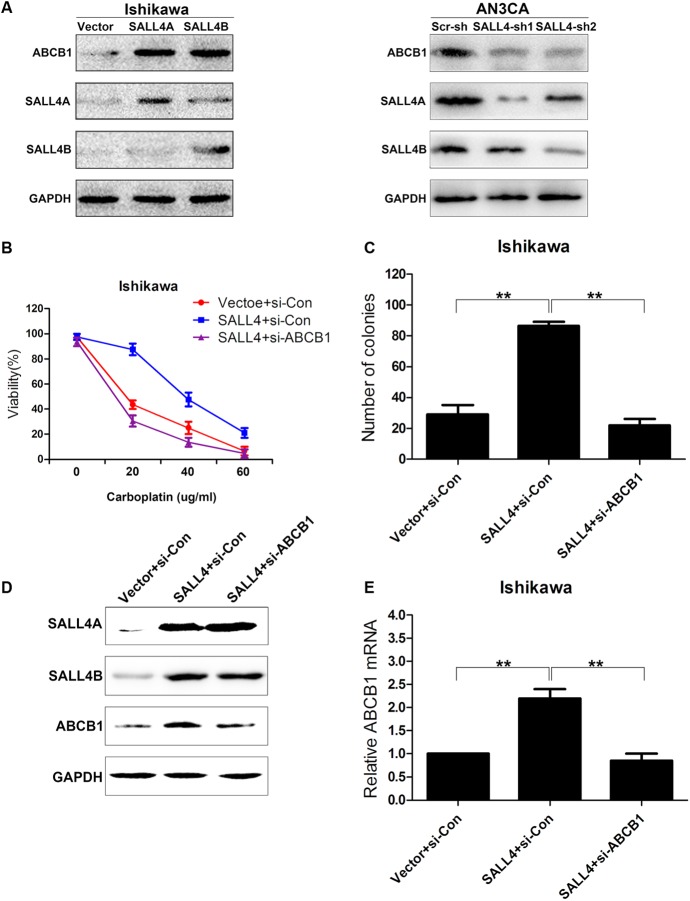
ABCB1 is critical for SALL4-induced drug resistance.(A) Western blotting showed that ectopic overexpression of SALL4 upregulated ABCB1 protein expression in Ishikawa cells and knockdown of SALL4 in AN3CA cells downregulated ABCB1 expression. (B)(C) Ishikawa cells transfected with SALL4A or SALL4B vector or control vector were transfected with si-ABCB1 or control siRNA. Drug sensitivity of Ishikawa cells to carboplatin was examined by cell viability assay and clone formation assay. (D)(E) The protein and mRNA levels of ABCB1 were assessed by western blotting and qRT-PCR. **P<0.01.